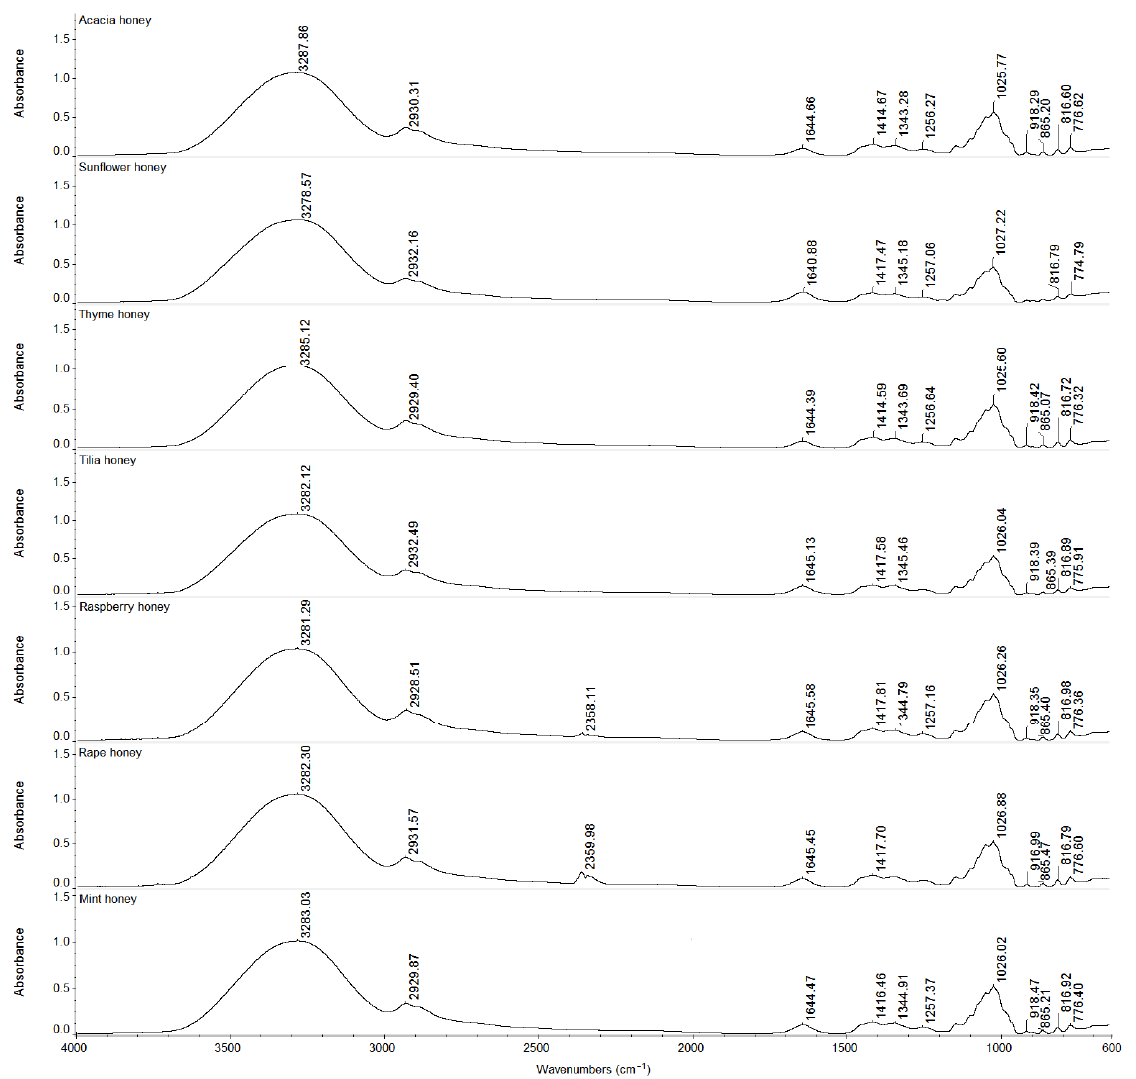
Figure 1. FT-IR spectra of honey samples of different botanical origins: raspberry, mint, rape, sunflower, thyme, acacia and tilia.